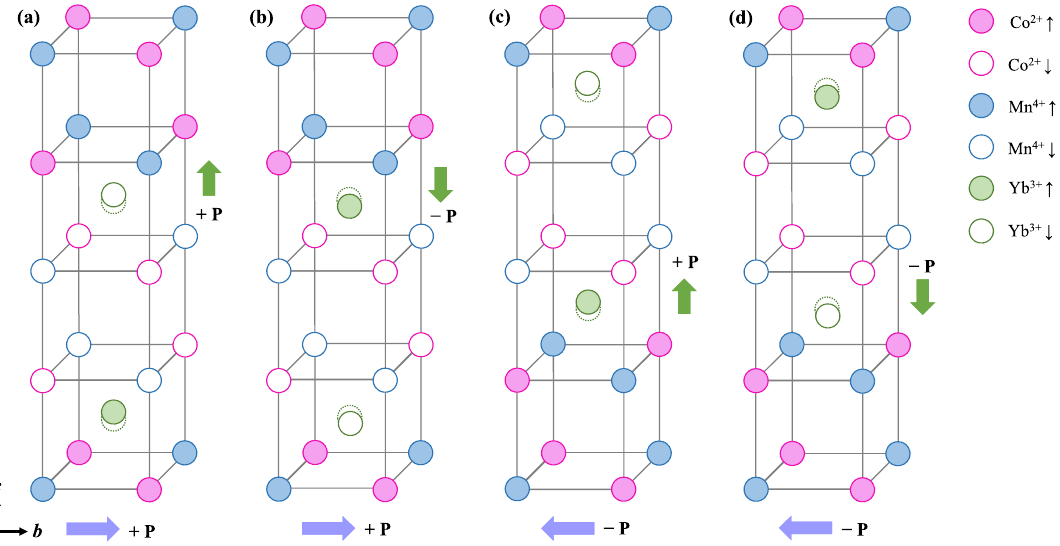
Figure 5. Proposed magnetoelectric domains of YCMO. Four types of magnetoelectric domains constructed from recent neutron diffraction experiments. The pink, blue, and green circles denote Co 2+ , Mn 4+ , and Yb 3+ ions, respectively. The filled and open circles represent up and down spins, respectively, and the green dotted circle indicates the original position of the Yb 3+ ions. In addition to P along the b axis, the exchange striction between Yb 3+ and Co 2+ /Mn 4+ magnetic moments induces P along the c axis. The four types of magnetoelectric domains are distinguished as ( P b , P c ) = (+, +), (+, −), (−, +), and (−,